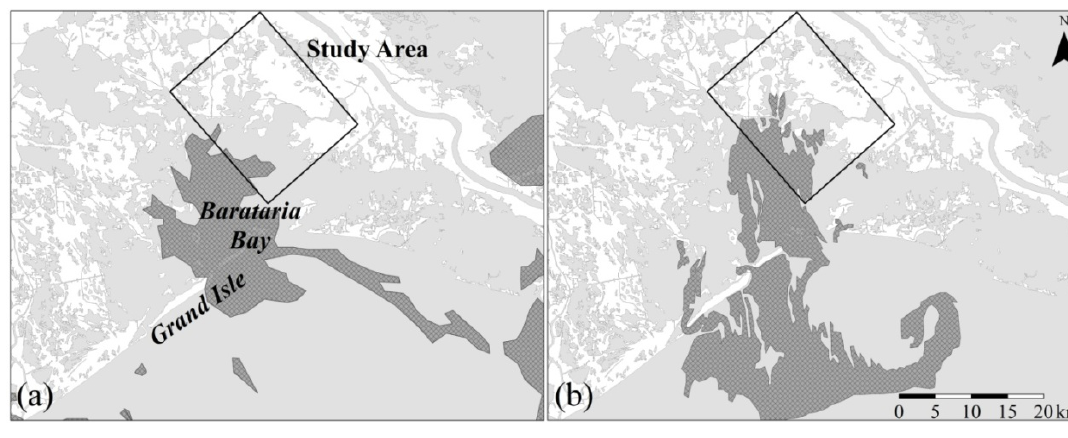
Figure 4. Outlined areas showing extensive oil slicks in Barataria Bay, Louisiana, derived from satellite observations on (a) 23 May 2010 and (b) 4 June 2010